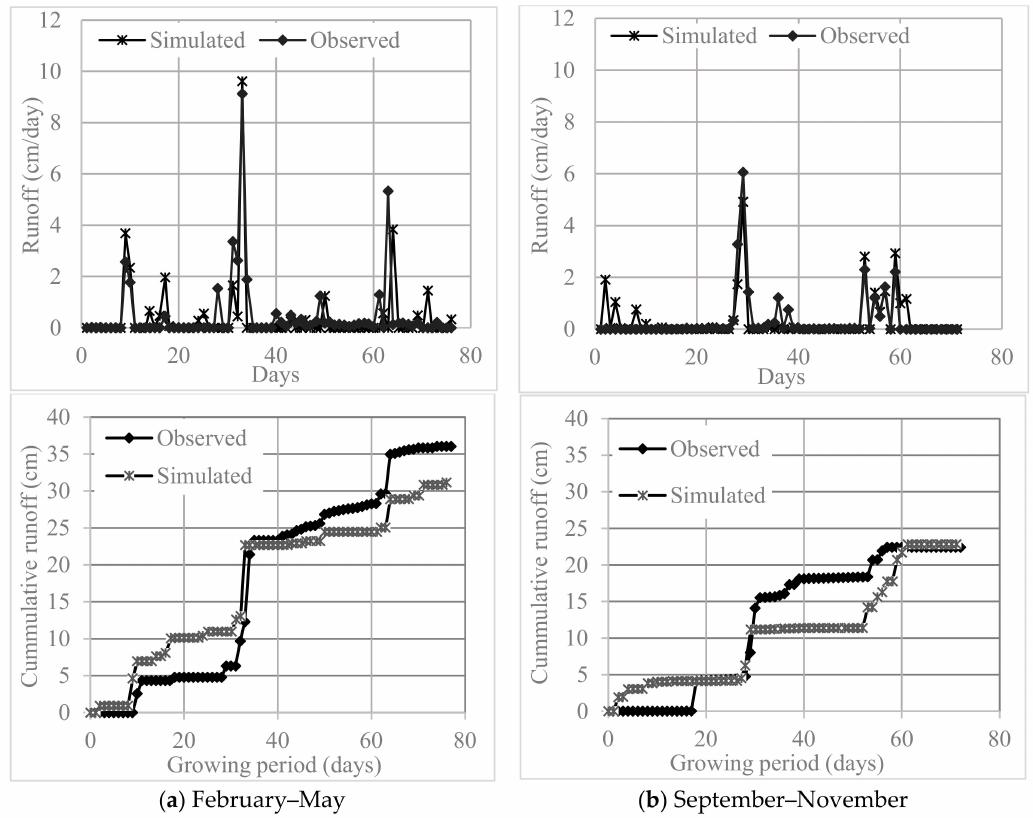
Figure 8. Simulated and observed surface runo ff during two growing